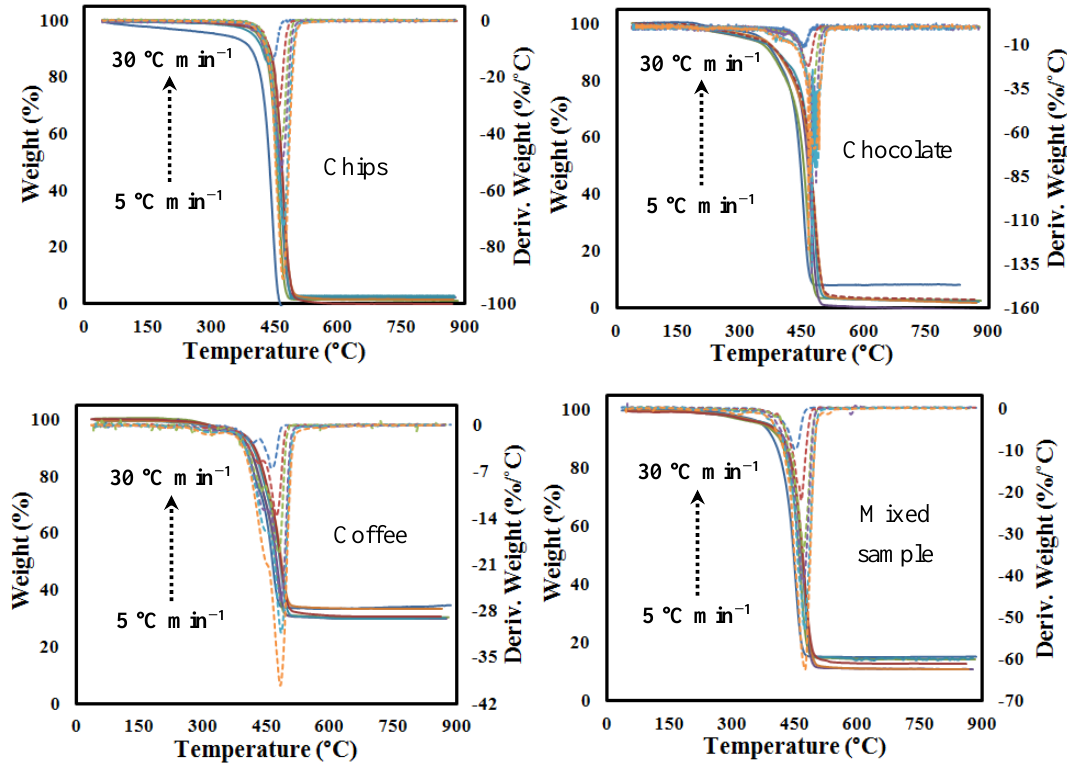
Figure 1. Experimental TGA (solid lines) and DTG (dotted lines) curves at the di ff erent heating rates of MFPW